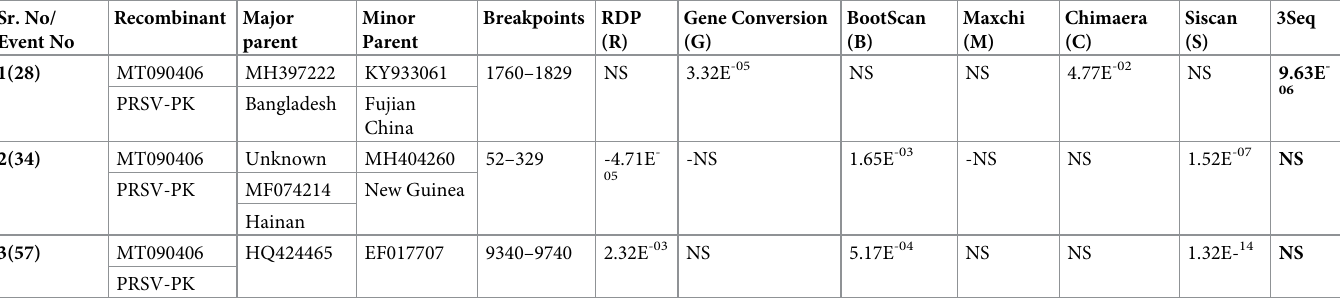
Table 4. Recombination detection in full length atypical PRSV–P Isolate PK